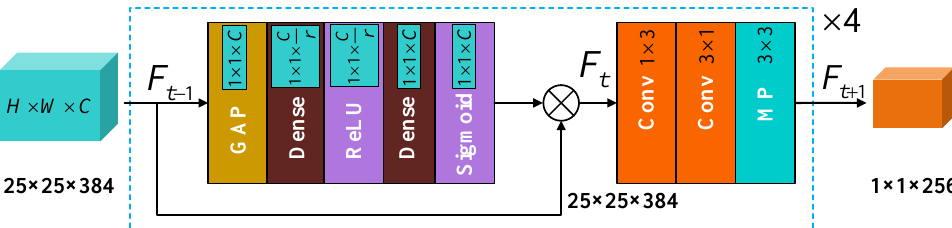
Figure 3. Overview of the enhanced feature extraction model, where F t − 1 is the input feature, F t is the middle feature, and F t + 1 is the output feature of the enhanced feature extraction